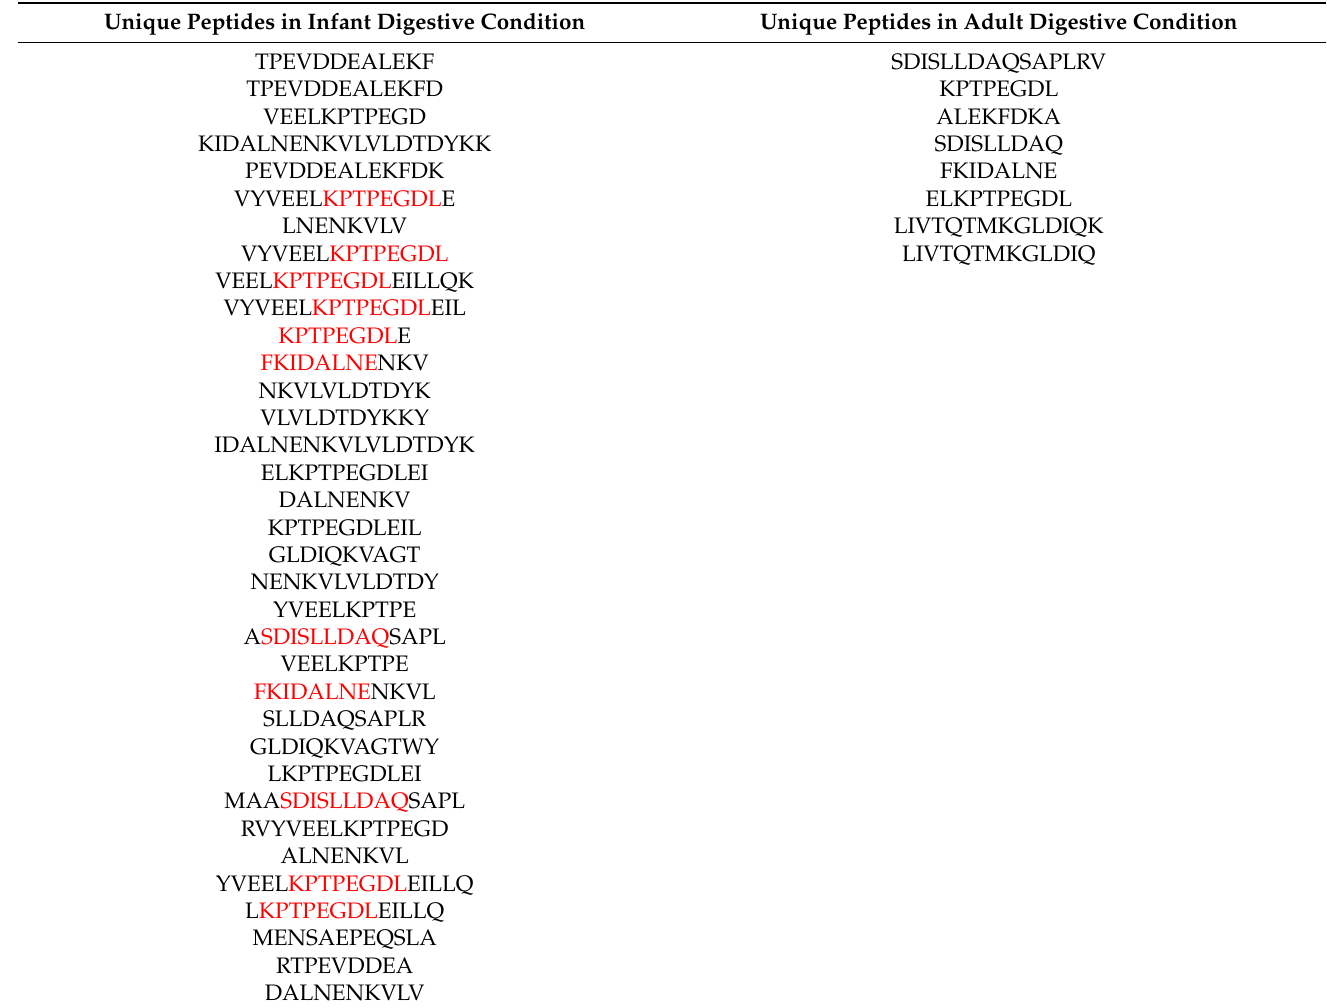
Table 2. The sequences of unique peptides of BLG remaining in infant digestive condition and adult digestive condition, respectively. The red letters in the infant column indicated that fragments of unique peptides existed in the simulated adult digestive condition that could be found intact in the infant digestive peptide segment. BLG, β